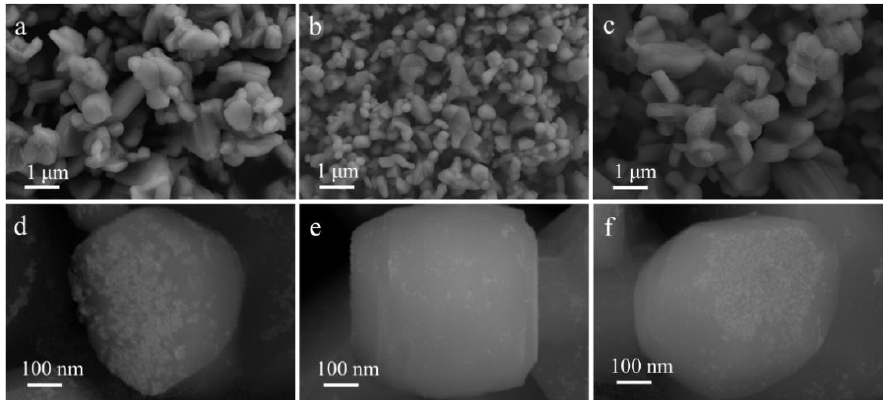
Figure 2. SEM images of ( a , d ) KFAM-1, ( b , e ) KFAM-2 and ( c , f ) KFAM-3.